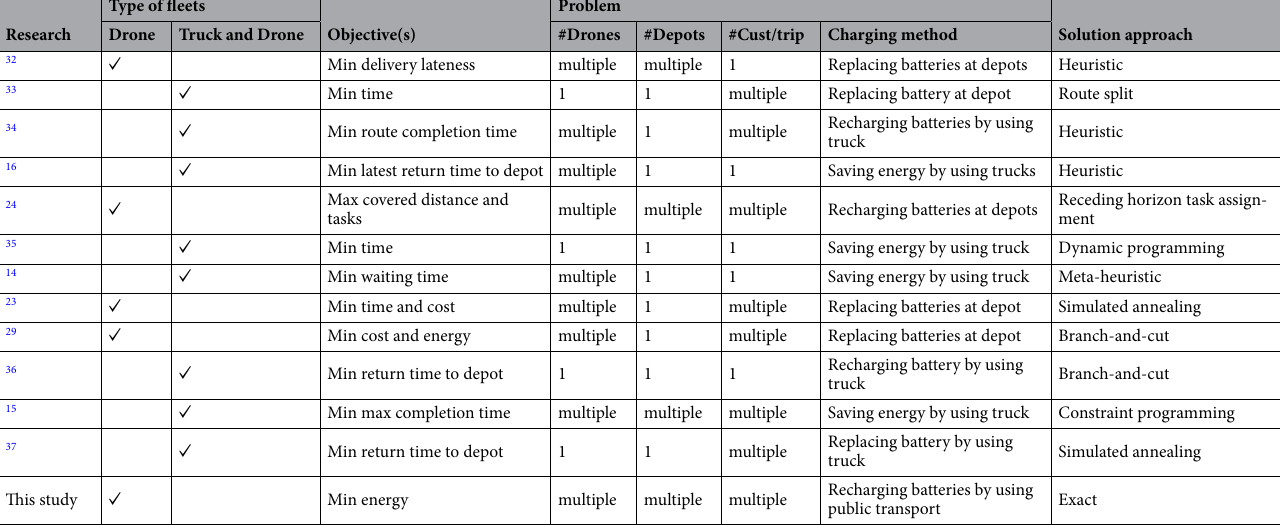
Table 1. Summary of papers on drone delivery routing problem. # cust/trip: number of customers per drone